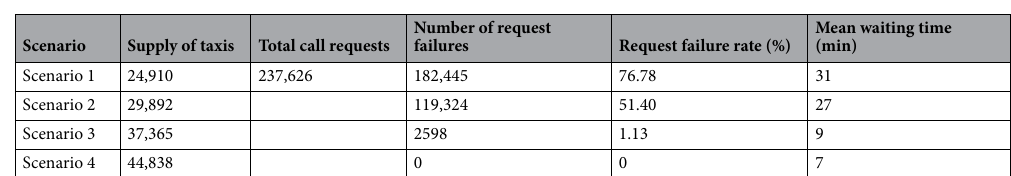
Table 5. Changes in Level of Service of taxis by increasing the number of vehicles in Seoul Metropolitan Area during late-night hours (10:00 p.m.–2:00 a.m.): Service level was evaluated by request failures and waiting time of